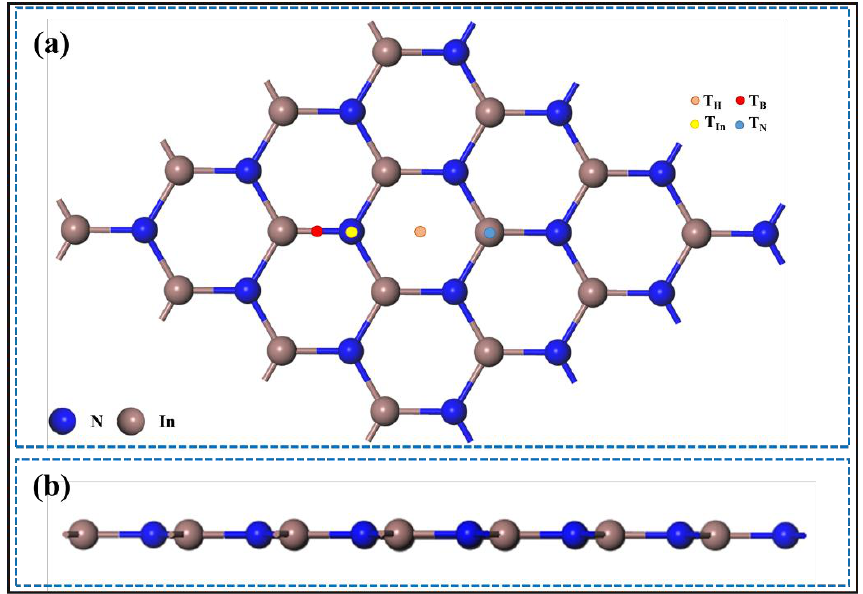
Figure 1. ( a ) Top view and ( b ) side view for geometric construction of the pristine InN monolayer. There are four possible doping sites on an InN monolayer—the T H , T B , T In , and T N sites [17]. In order to determine the most stable construction of a Cr-doped InN monolayer, four kinds of Cr-decorated InN monolayers based on the abovementioned four doping sites were established; their formation energy and charge transfer were calculated and comprehensively compared to select the most stable doped structure with the best parameters as the basic model for subsequent adsorption calculation. The most stable structure of Cr–InN is exhibited in Figure 2a, which shows that the Cr atom is located at the T In site and the InN monolayer accepts 0.053 e electrons from Cr atoms and forms bonds with Cr atoms, releasing 0.64 eV of energy and indicating that the reaction can spontaneously proceed.